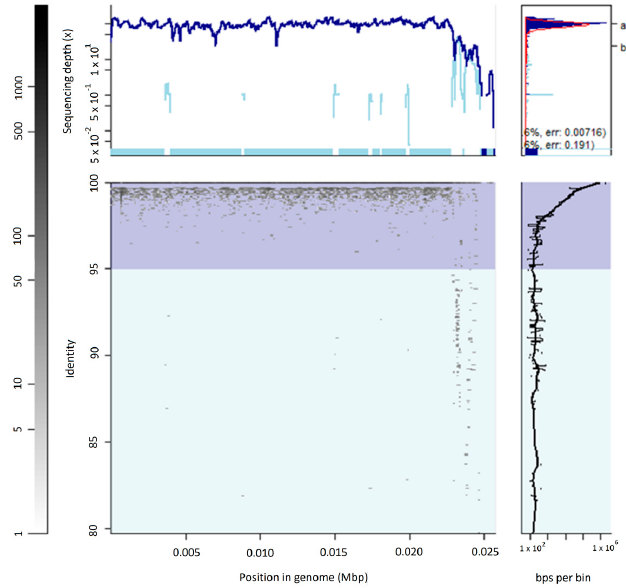
Figure 3. Viral metagenomic fragment recruitment of vSAG 92-1-C13 in the virome sample SV92. This vSAG is fully recruited with reads at 99–100% identity. Sequencing coverage and total recruited nucleotides at different identity percentages are depicted.